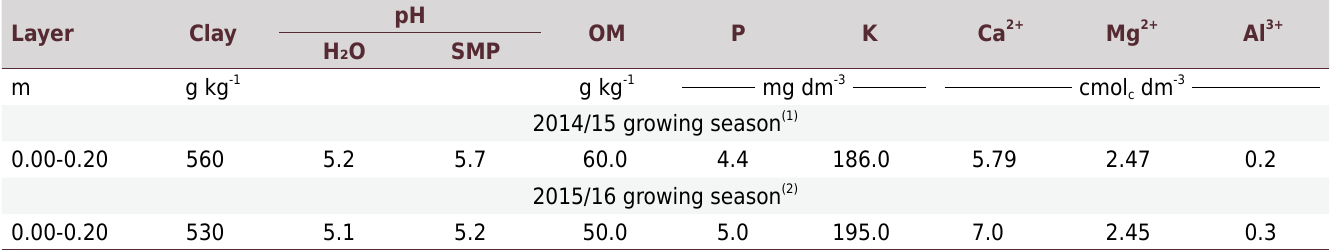
Table 1. Chemical properties of the soil in the experimental area during the 2014/15 and 2015/16 growing seasons, in Lages, Santa Catarina, Brazil Layer